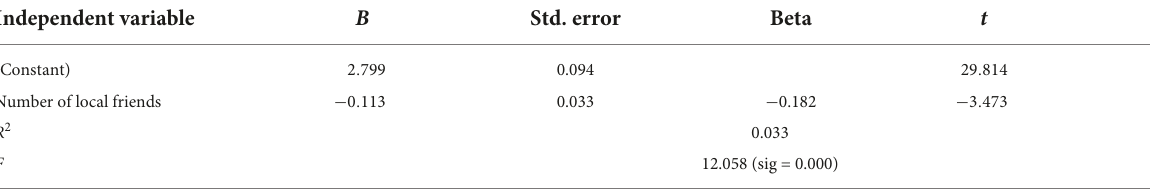
TABLE 3 Regression test of the number of local friends on intercultural adaptation stress. Independent variable